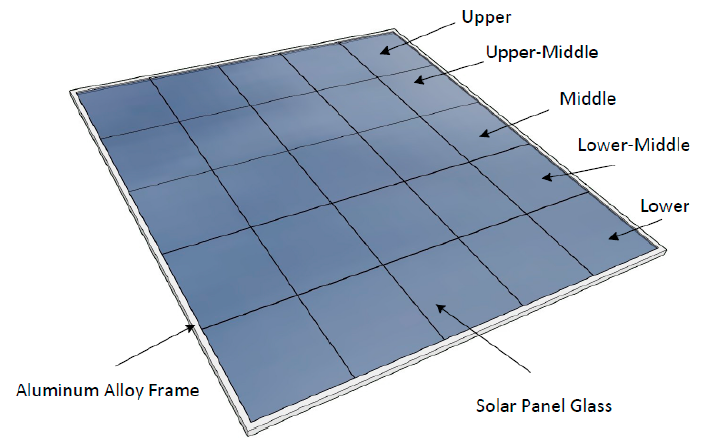
Figure 2. Schematic diagram showing the position of the glass side of the solar panel. Wind direction and speed data were provided by the Environmental Protection Agency of Taiwan. The location of the actual measurement site was Taichung City, Taiwan. The monthly average wind speed was between 1 and 2 m/s